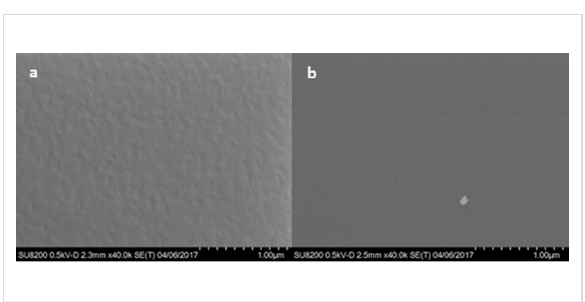
Figure 9: SEM images of (a) the Ti-uracil film deposited (at 225 °C, 19 nm) and (b) the Ti-thymine (at 250 °C, 15 nm) after exposure to water; scale bar 1